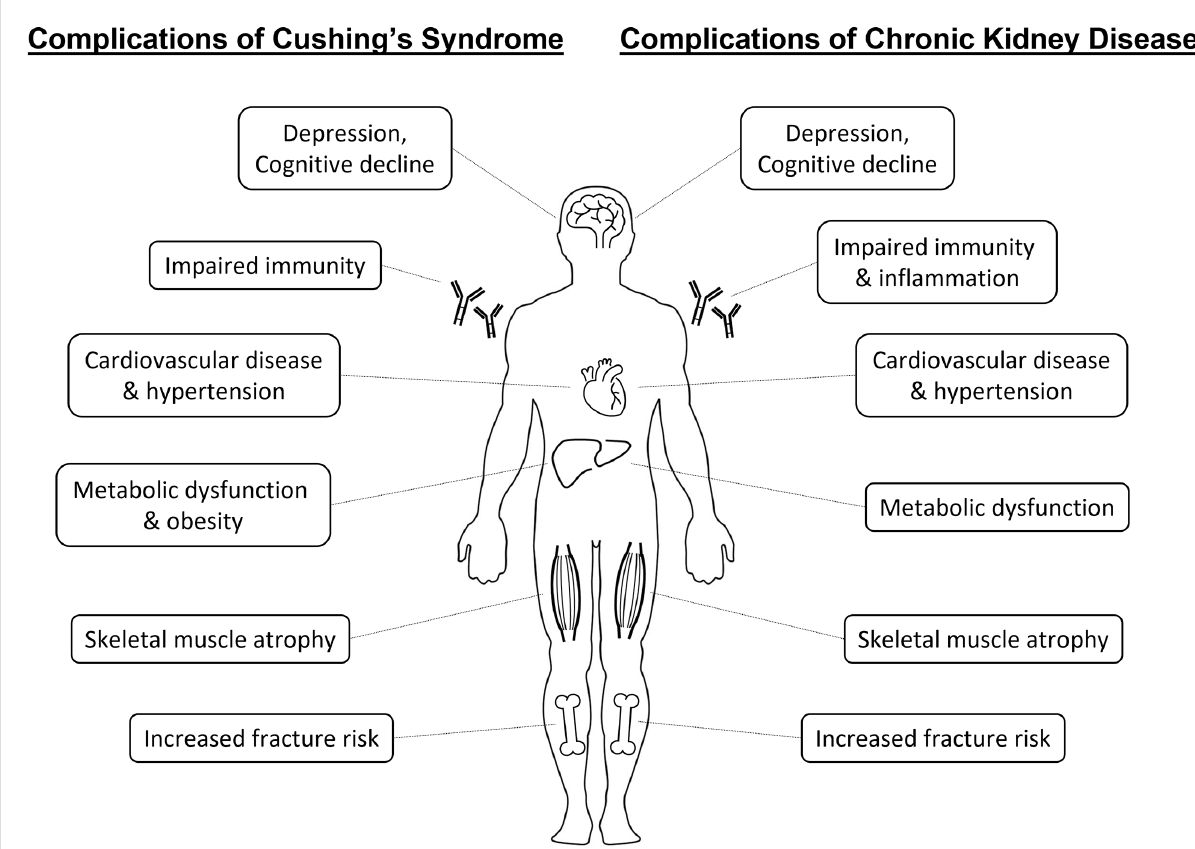
FIGURE 1 Similarities between systemic complications of Cushing ’ s syndrome and chronic kidney